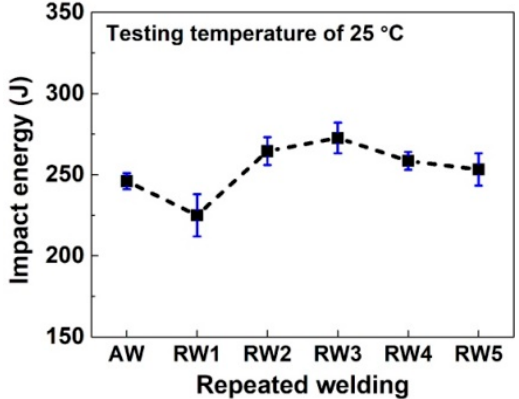
Figure 15. Impact energy of the AW, RW1–RW5 specimens by the as-welded and repeated welding in Gleeble weld-simulator at room temperature.